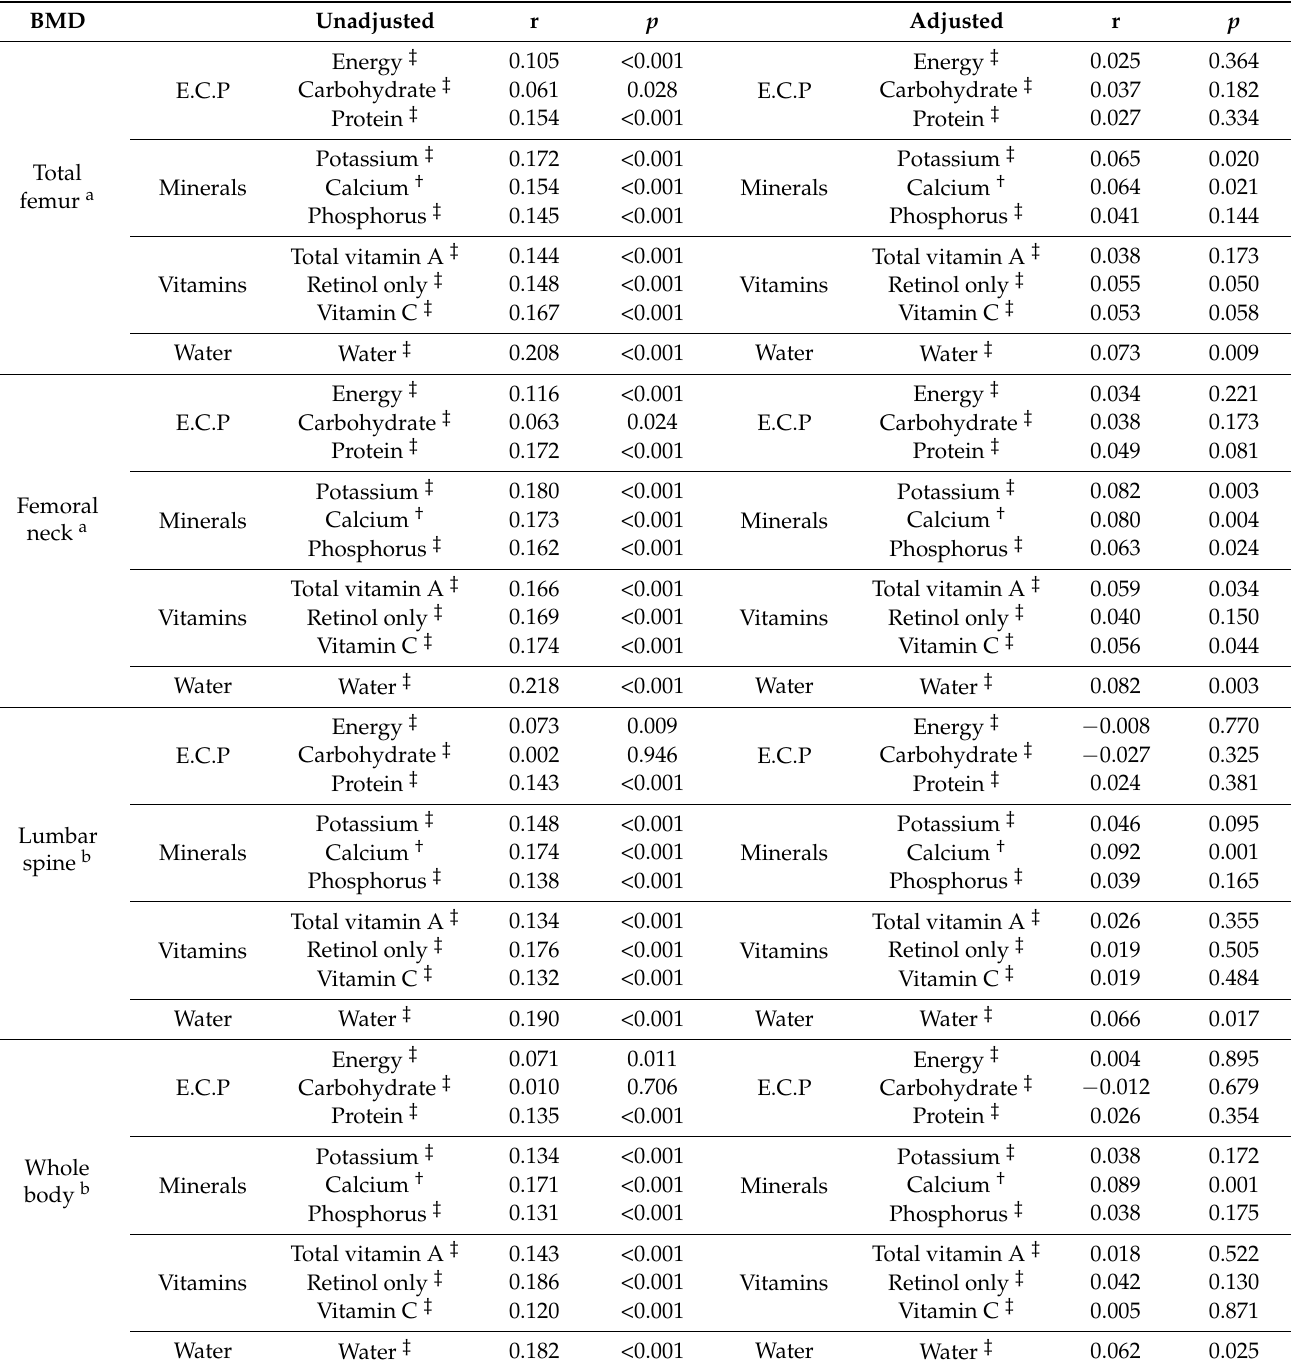
Table 10. Partial correlation coefficients between nutrient intake and bone mineral density in postmenopausal women.